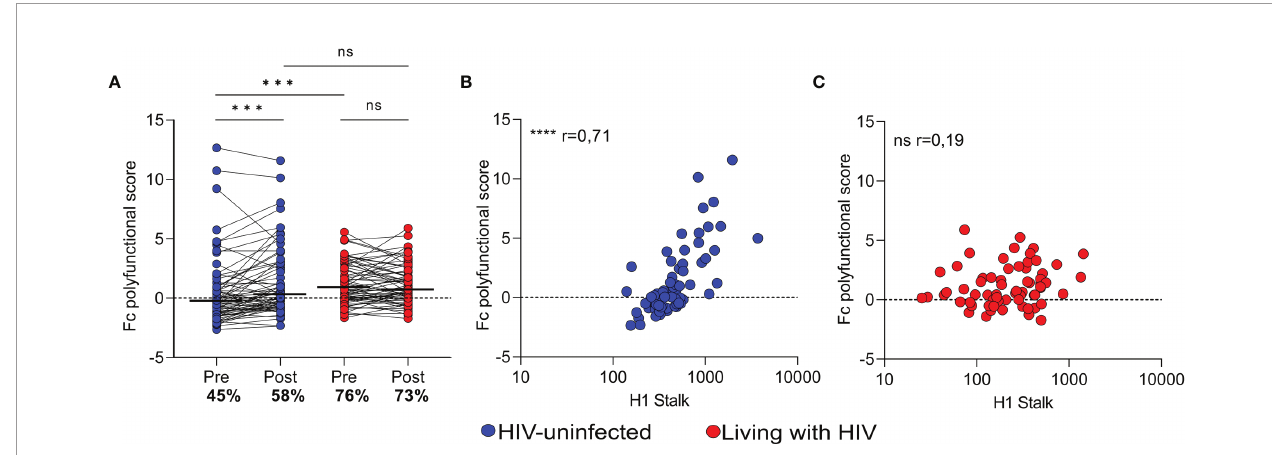
FIGURE 4 | HA stalk-speci fi c Fc polyfunctionality scores of Fc-mediated functions amongst vaccinated women. (A) Fc polyfunctionality (determined by the addition of individual standardized Fc function scores), prior to and following vaccination. Dots above 0 indicate Fc polyfunctional individuals, while those below indicate poor Fc polyfunctionality below the mean. The proportion (%) of individuals with Fc polyfunctionality is indicated on the plot. Spearman´s correlation between the Fc polyfunctionality score and HA stalk response in (B) HIV-uninfected women and (C) WLWH. Wilcoxon matched-pairs signed rank test was used to compare pre- vaccination and post-vaccination polyfunctionality scores within groups. Mann Whitney U test was used to compare polyfunctionality scores between the vaccine groups. Signi fi cant associations are shown as ****p < 0.0001; ***p < 0.001; ns,not signi fi